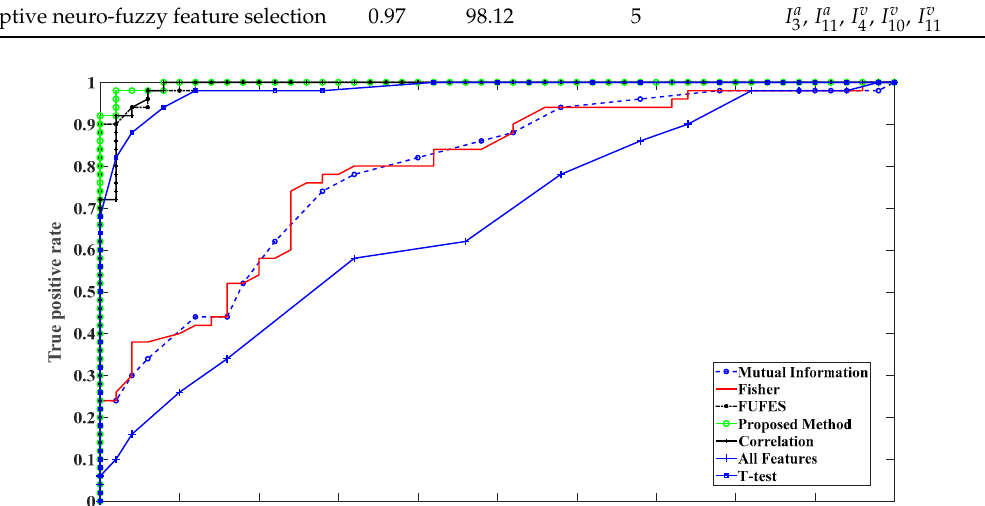
Figure 6. Receiver Operating Characteristic (ROC) curve for evaluation of classifier performance with different feature selection methods.